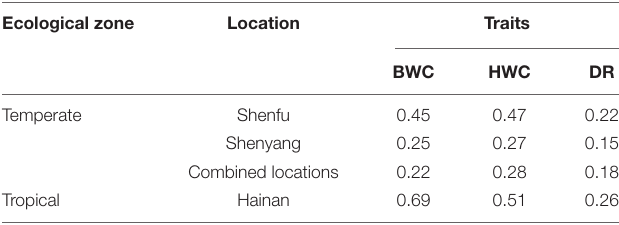
TABLE 1 | ST-GBLUP heritability estimates for BWC, HWC, and DR within each agro-ecological zone and location. Ecological